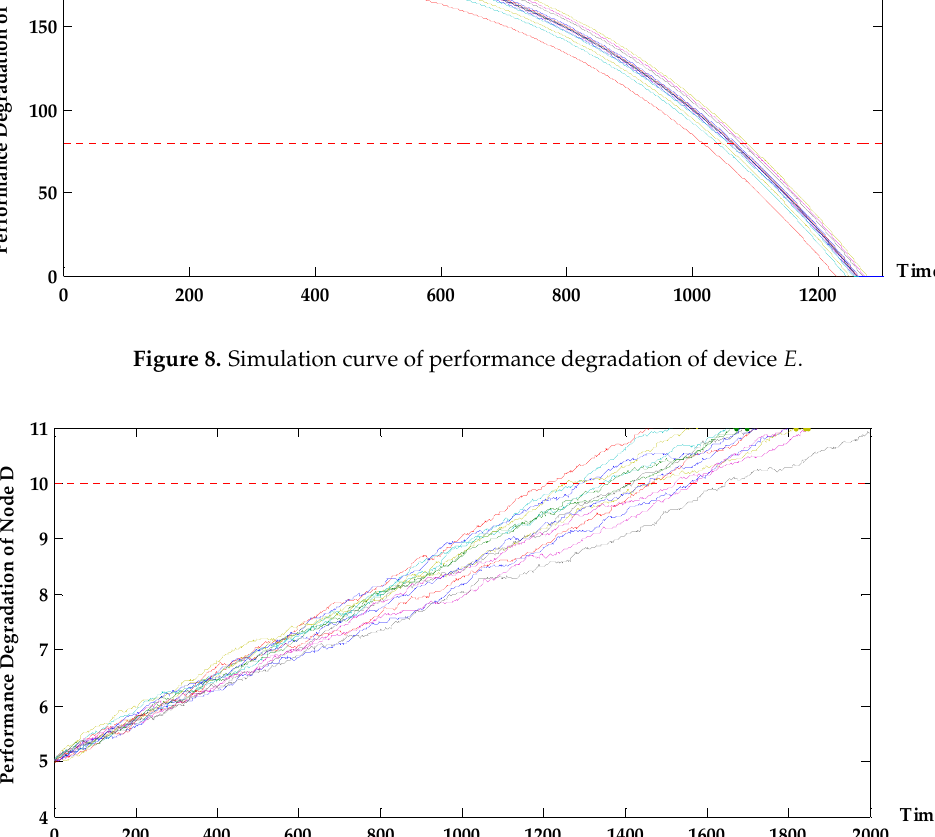
Table 3. Prediction model (2) of four pieces of equipment 1 .